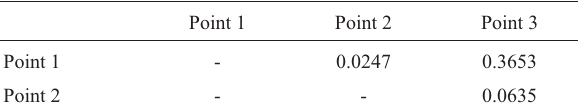
Table 2 - p- values of the contingency test between sample pairs. Point 1 - Bicudo River, Point 2 - Poço Claro River, Point 3 - nameless stream.